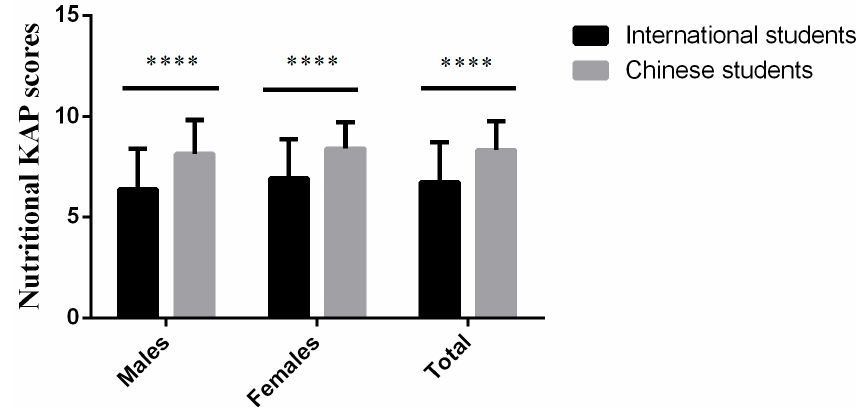
Figure 1. Comparison of nutritional KAP scores between international and Chinese students. Nutritional KAP scores were compared between International students and Chinese students. **** indicates the significant difference ( p < 0.0001) by Mann Whitney test. International males = 110, Chinese males = 115, International Females = 198, Chinese Females = 278, Total International students = 308 and Total Chinese students = 393.